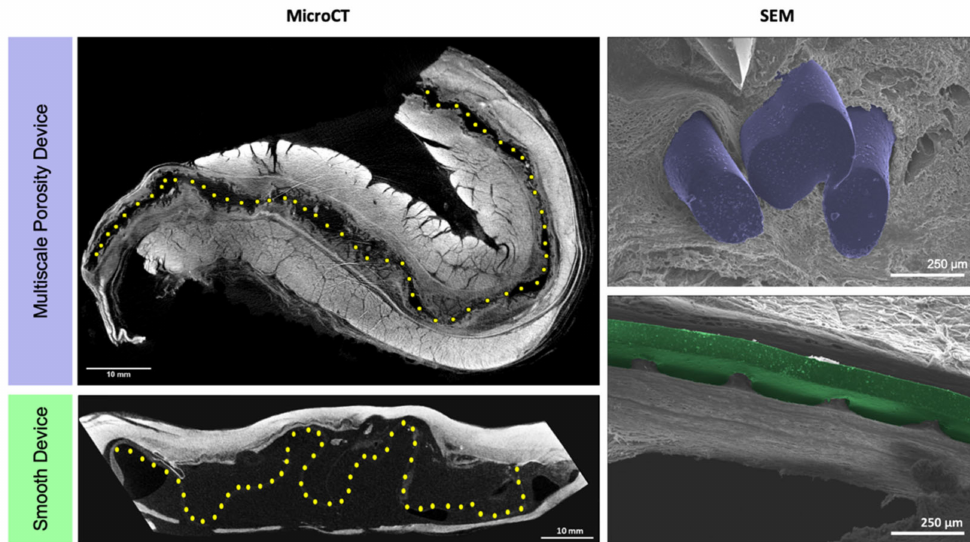
Figure 5. MicroCT cross sectional images ( left column) of multiscale porosity and smooth surfaced devices, demonstrating their relationship with the surrounding tissue. Yellow dots are indicative of device location. Scale bars = 10 mm. High magnification SEM images ( right column) of rope-coil surface features (blue) integrated into the surrounding tissue and reduced integration surrounding the smooth device (green). Scale bar = 250 µ